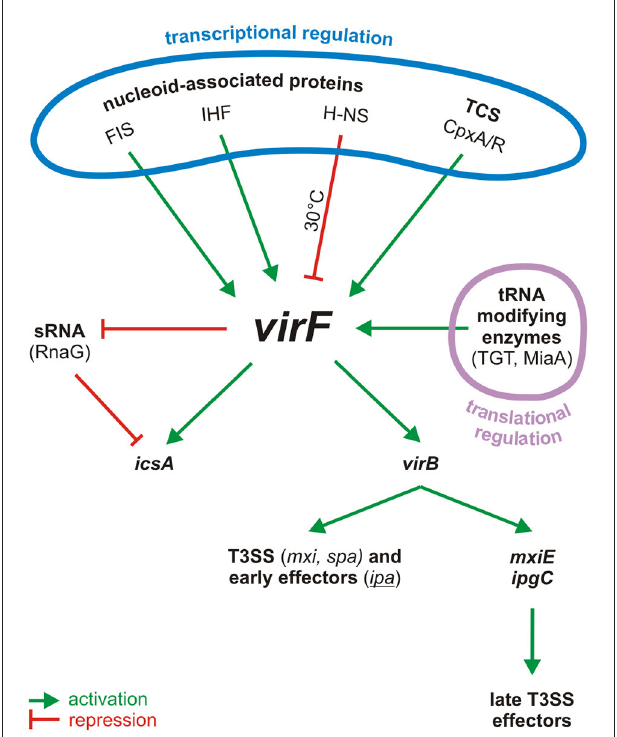
FIGURE 1 | Centrality of VirF in the pINV regulatory cascade of Shigella . The control of VirF occurs at transcriptional and translation levels. The major proteins involved in the regulation of VirF in response to environmental stimuli and nutrient conditions are indicated. Once synthesized, VirF activates the icsA and virB genes and represses the synthesis of the sRNA RnaG. VirB, the second regulator, then activates several operons, including those for a T3SS system and for the early effectors. VirB activates also the last regulator, MxiE, which in association with IpgC activates the late effectors. TCS, two component